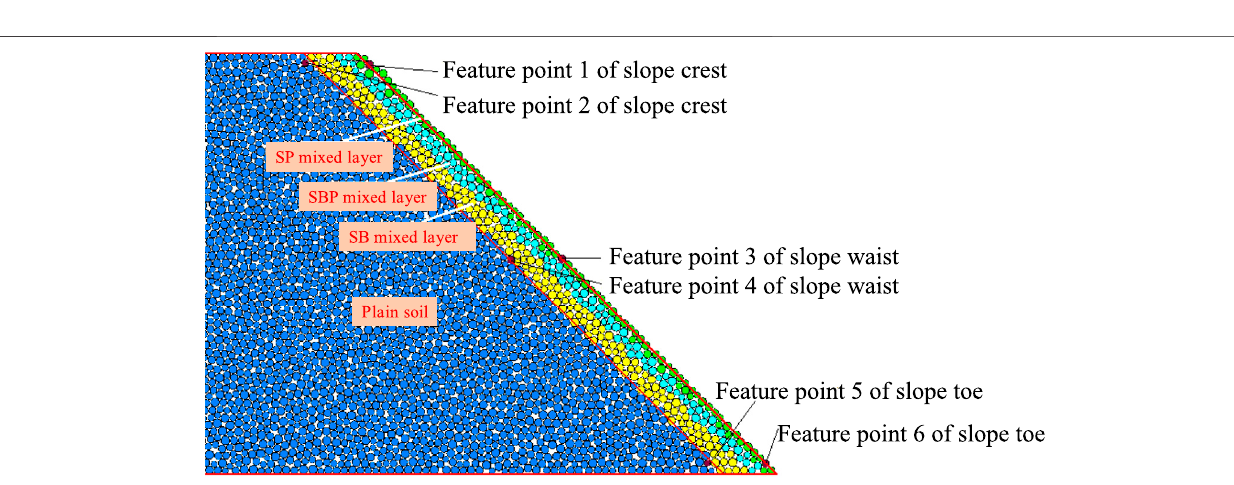
TABLE 10 | Erosion depth of subgrade slopes with and without composite protection surfaces.